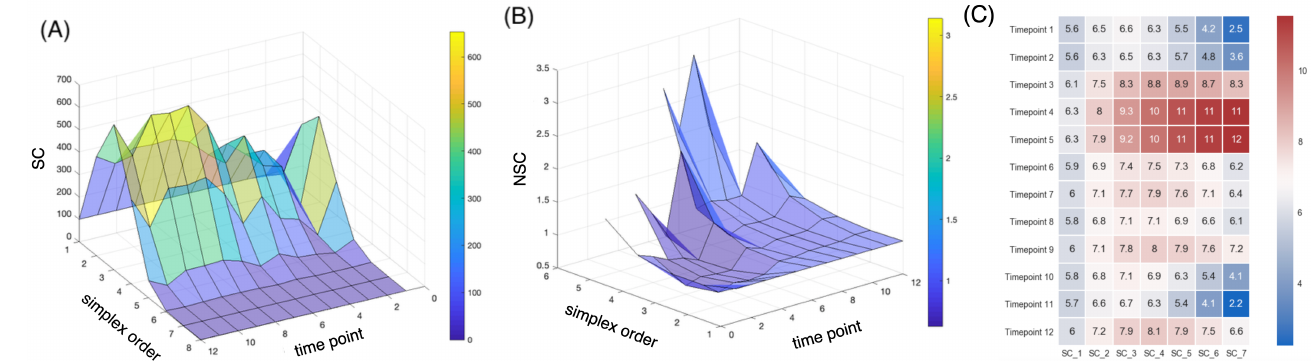
Figure 7. Simplicial dynamics across developmental stages. ( A ) The number of n -simplices is com- puted from the sampled data points in each time point. ( B ) The normalized n -simplicial complexity (i.e., the normalized number of n -simplices) is computed as the ratio of the number of n th-order simplicial complexes from the data to the number of those from the null models. The normalized simplicial complexity of a higher order appears to be well above one in certain developmental stages, with a distinctive separation between the fifth and sixth time points. ( C ) The heat map of the normalized n -simplicial complexity across the time points supports the